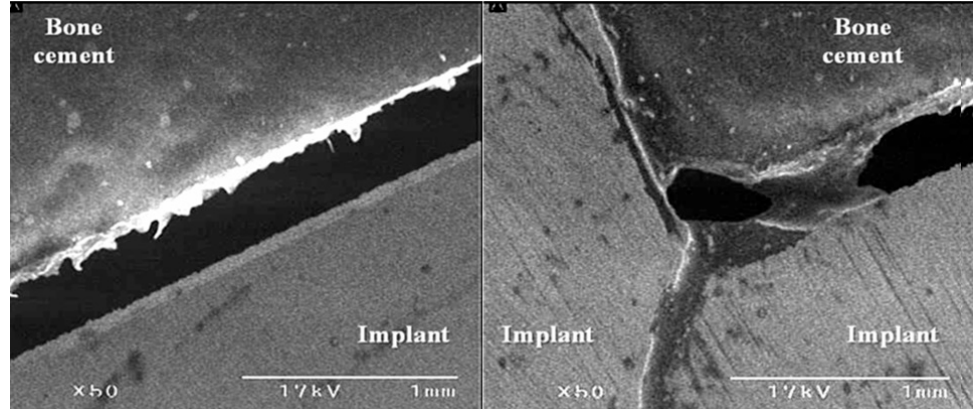
Figure 8. Scanning electron microscopy of the interface between the femoral head implant and bone cement.